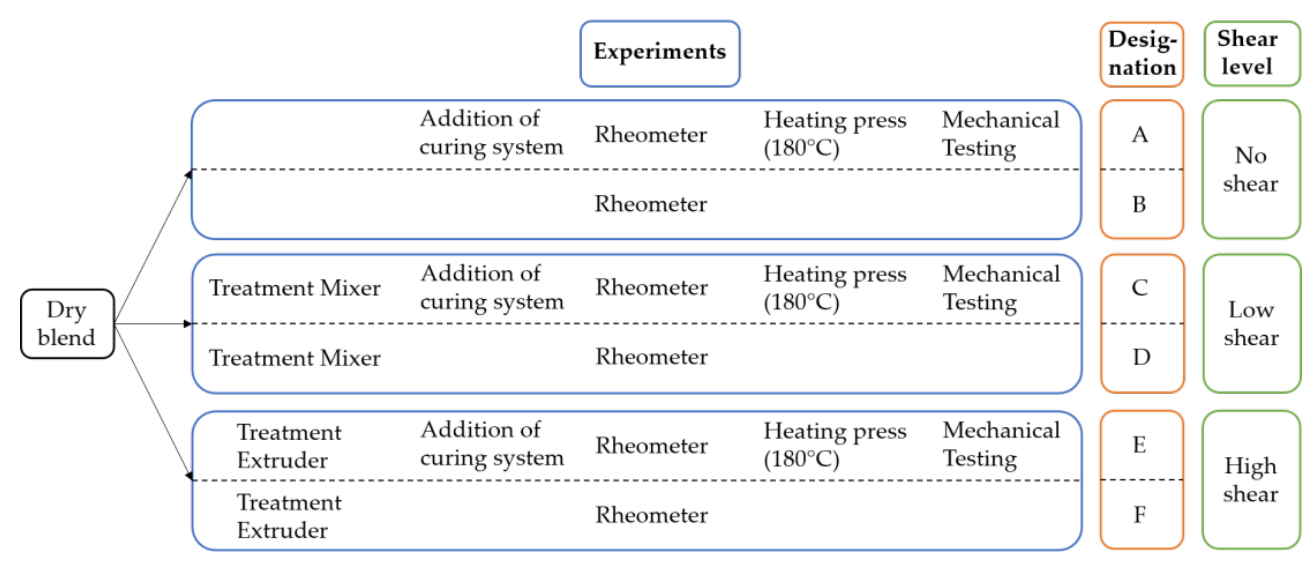
Figure 13. Overview of experiments, designation, and shear level.